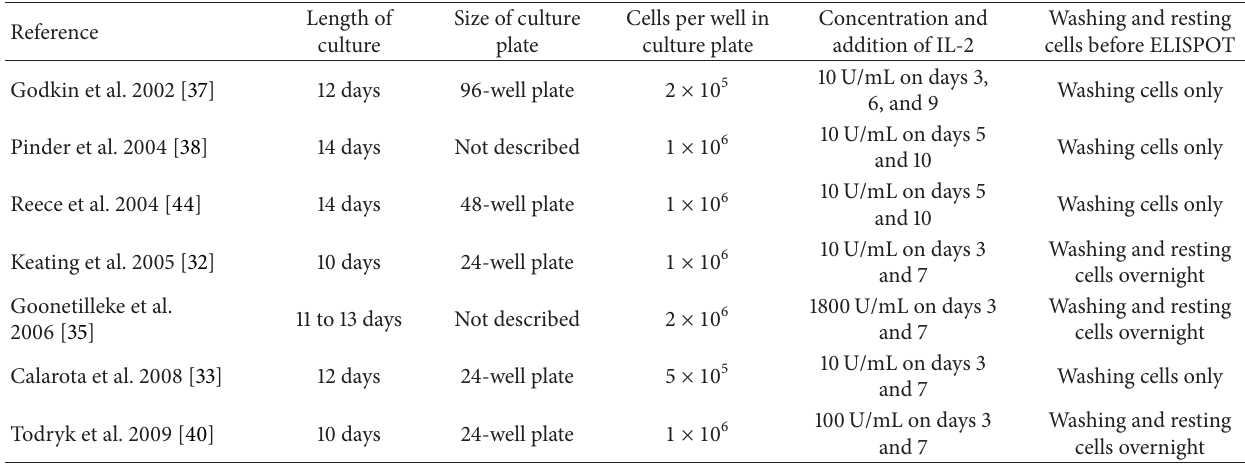
Table 1: Variants of cultured ELISPOT